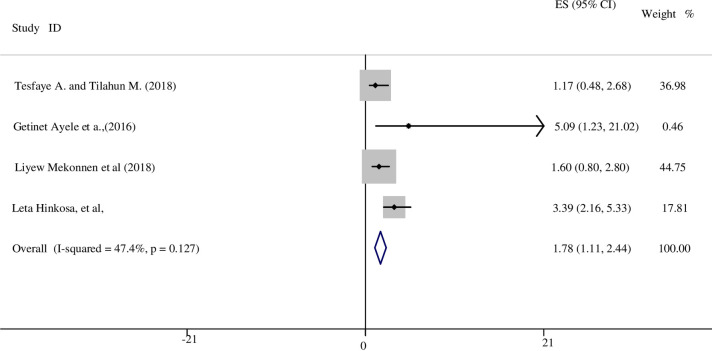
The association between parity and HDP in SSA.